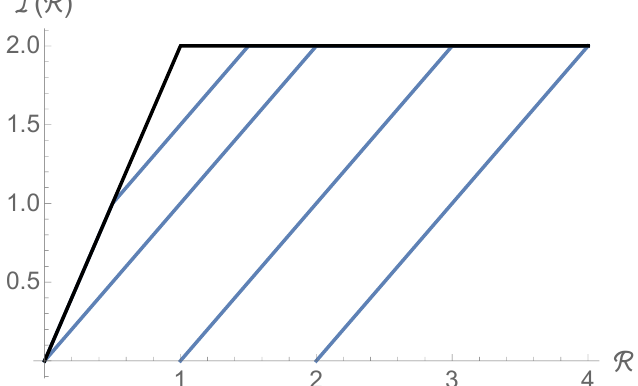
Figure 16. Mutual information from the two-sided extremal surfaces in d = 2. The black line is the result for time = 0, while the blue lines correspond to T caption of (cid:12)gure 14, the blue curves may start and end as